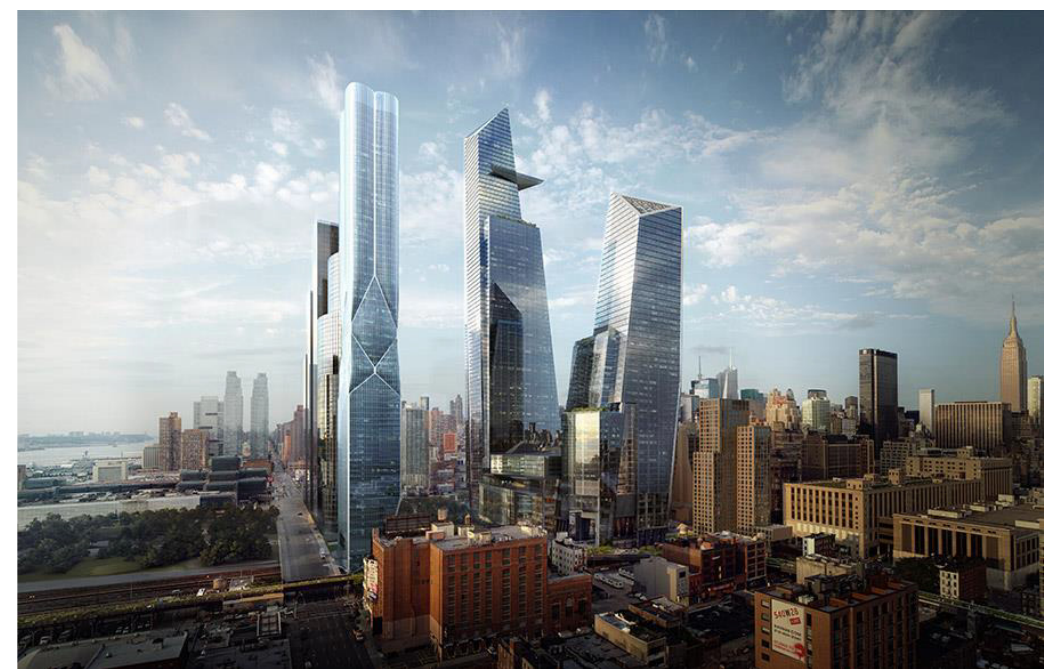
Figure 1. A rendering of Hudson Yards in Manhattan. Source: Klayko (2012). we can perceive it in reality, namely through certain colours, reflections, shadows, etc. As one visual